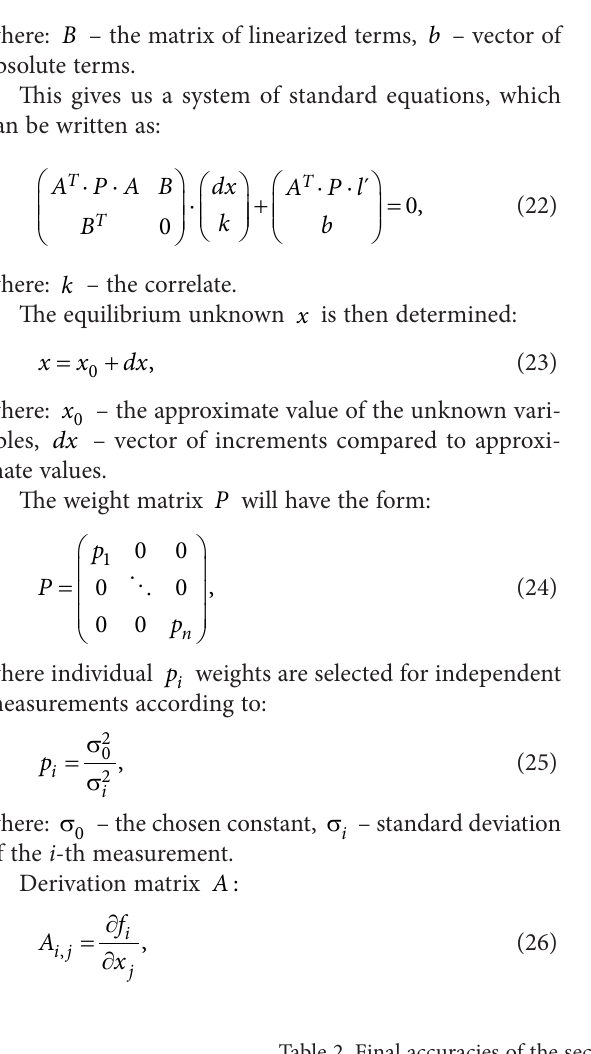
Table 2. Final accuracies of the secondary surveying network points Point